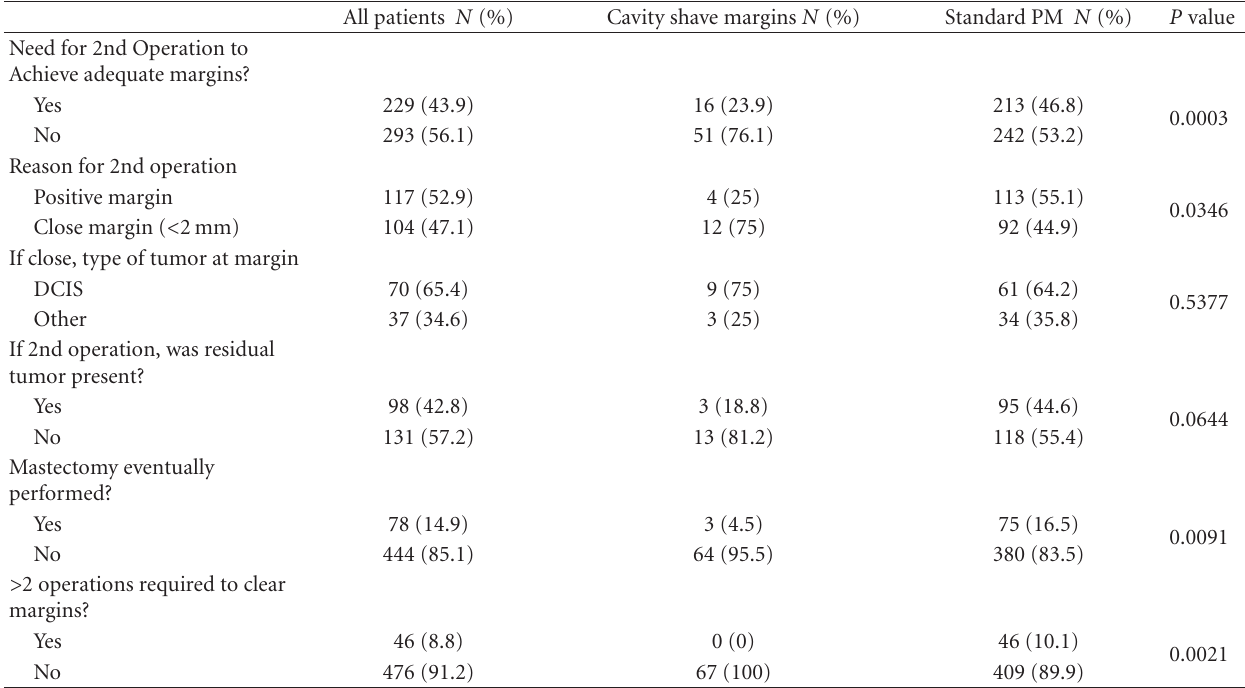
Table 2: Statistically significant di ff erences.